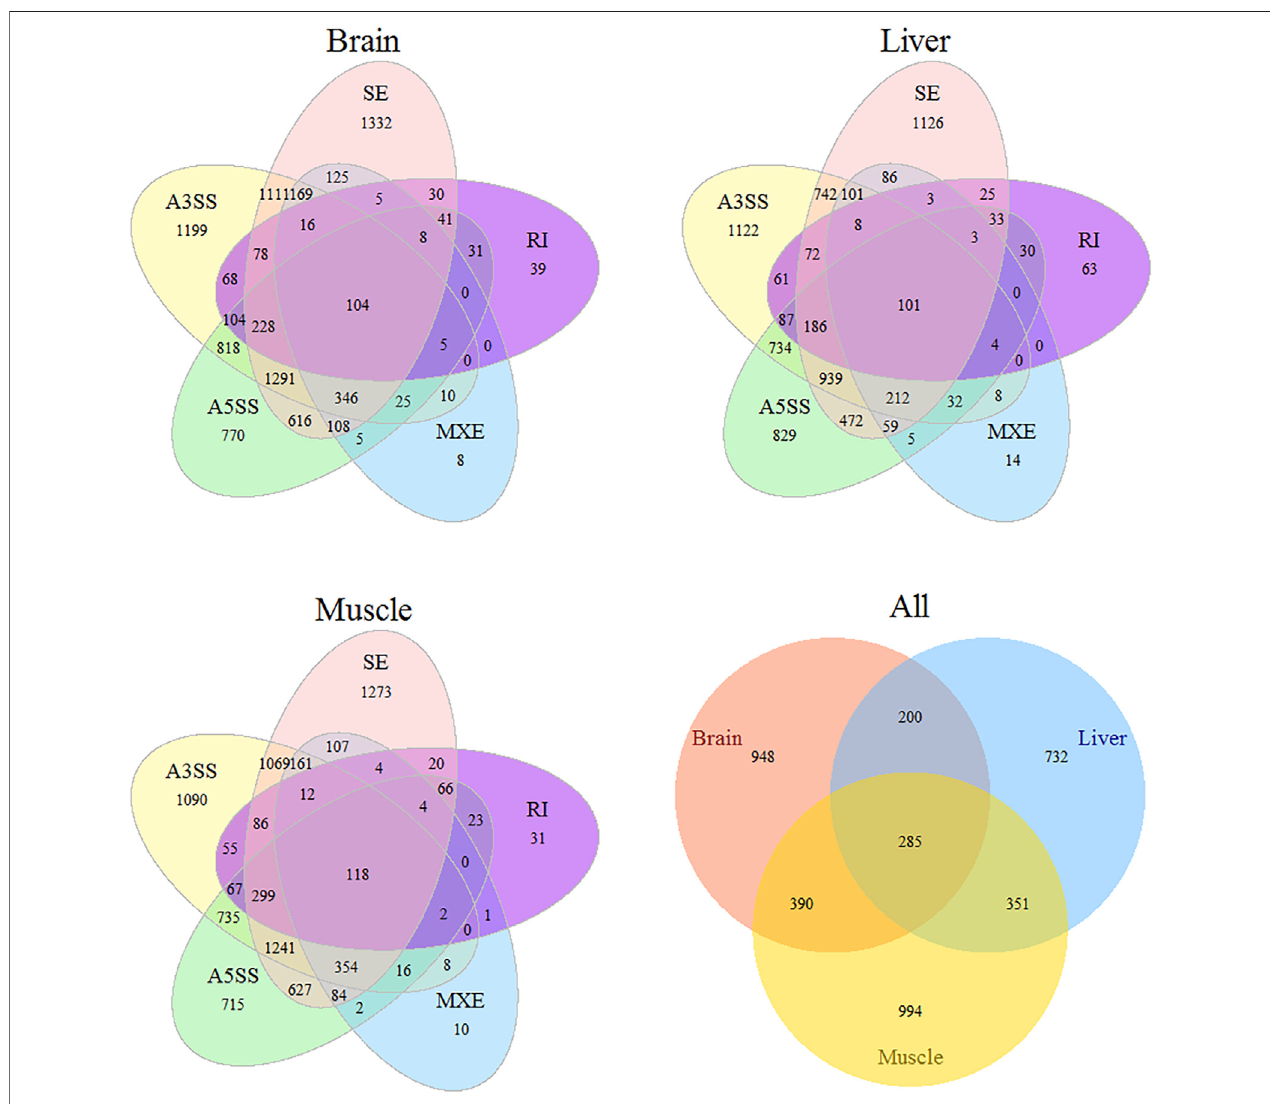
FIGURE 3 | Venn diagrams illustrating statistical results of different types AS in tissue and divergence AS among tissues.